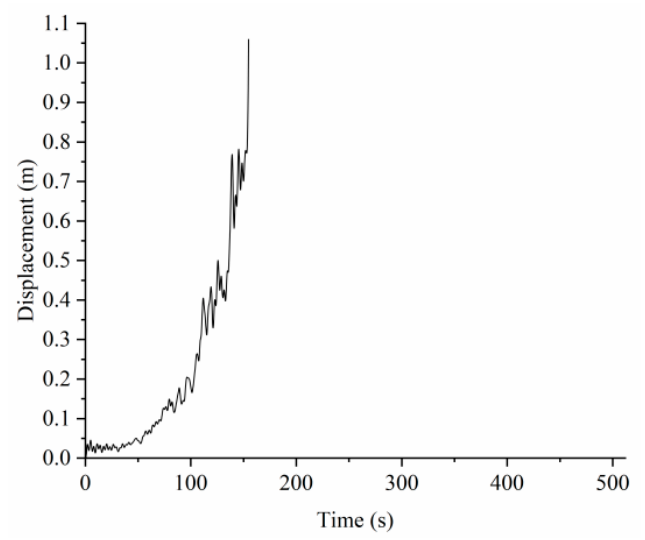
Figure 19. Displacement time history of transmission tower under 65 m/s downburst.